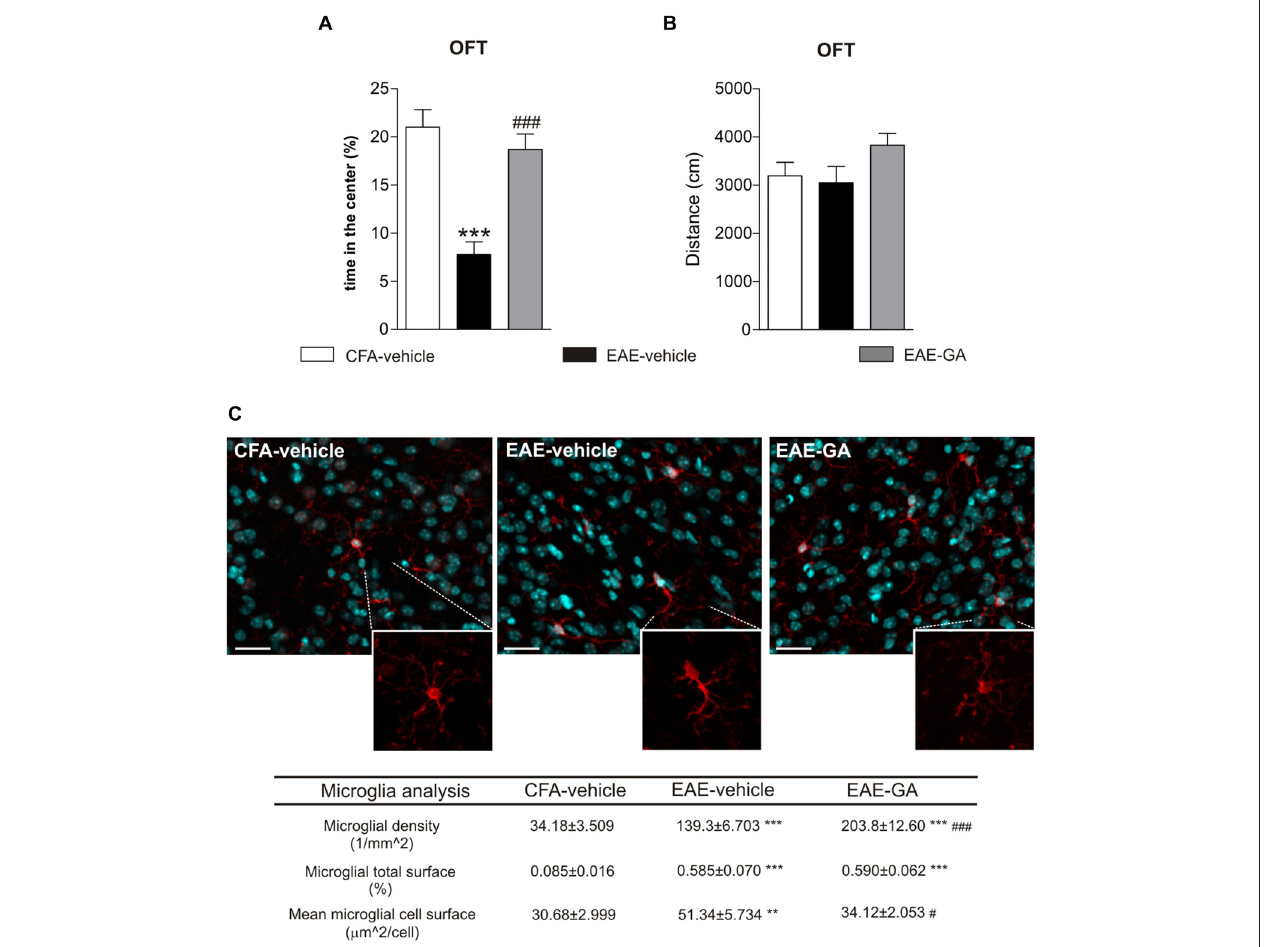
cell density in the striatum of control CFA-vehicle, EAE-vehicle and EAE-GA mice: Iba1 staining for microglia (red; counter-staining with DAPI–blue), reveals increase in microglial cell density in EAE-vehicle vs. CFA-vehicle striatum with further enhancement in EAE-GA striatum. Insets show different morphologies of microglial cells among the groups: microglia from EAE striatum is visibly hypertrophic if compared to both microglia from CFA-vehicle and EAE-GA striatum. Scale bar: 25 µ m. Quantitative and qualitative analysis of microglia, based on IBA1 immunofluorescence, is reported down the immunofluorescence images: GA increases microglia density and restores resting state of microglial cells. The morphological analysis of microglial cells, based on the area covered by IBA1 positive cells inside the striatum, shows the effect of GA in reducing microglial hypertrophy observed in EAE-vehicle, expressed as mean cell area, while the total microglial area is similar to EAE-vehicle microglia. For image acquisition and analysis method, refer to Gentile et al., 2013. Data are expressed as mean ± S.E.M. One-way ANOVA analysis, Tukey’s post hoc test: EAE-vehicle and EAE-GA vs. CFA-vehicle: *** p < 0.001, ** p < 0.01; EAE-GA vs. EAE-vehicle: ### p < 0.001, # p <